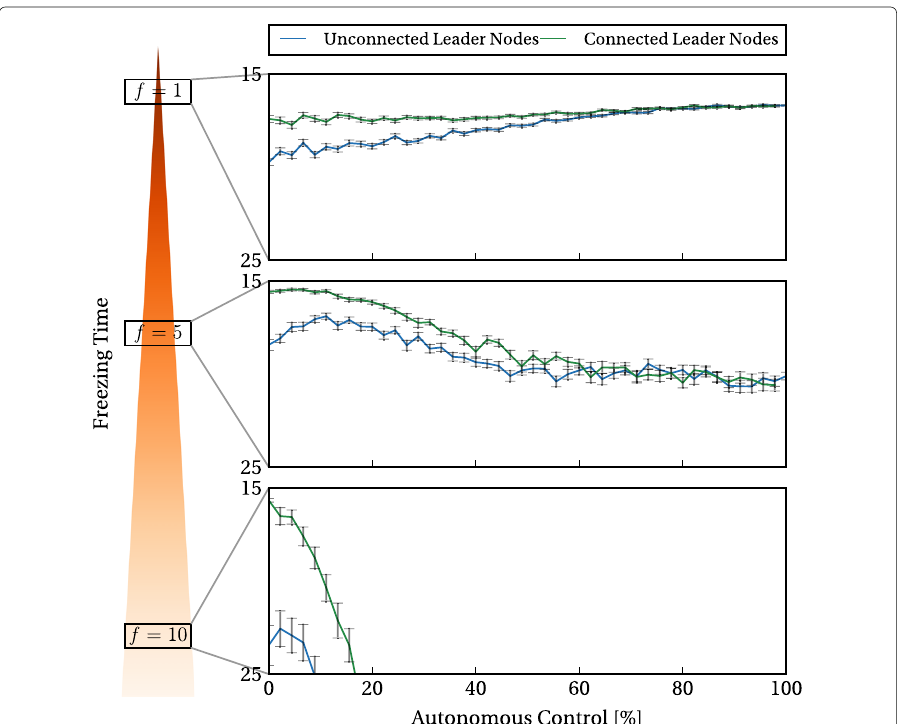
Fig. 6 Makespan of the scheduling problem as a function of the level of autonomous control and freezing time. Makespan is shown on y -axis, inverted to reflect notion of performance. n = 60, χ = 4, s =